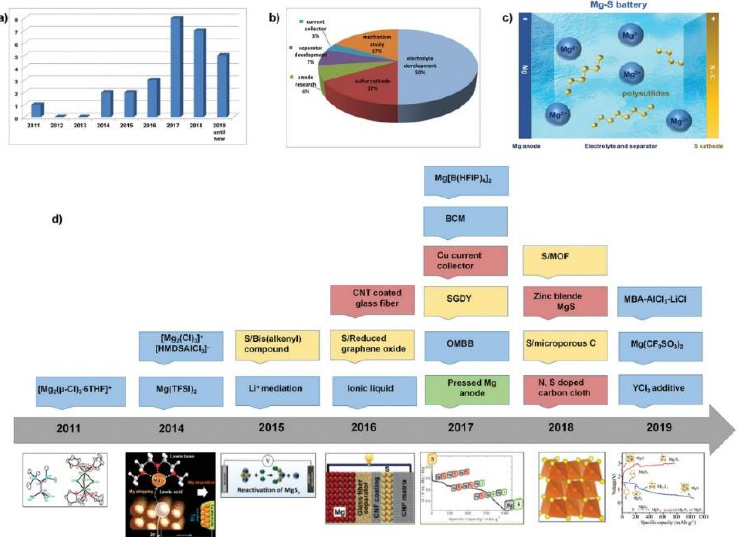
Figure 1. Scheme of an Mg–S cell. Based on [20].